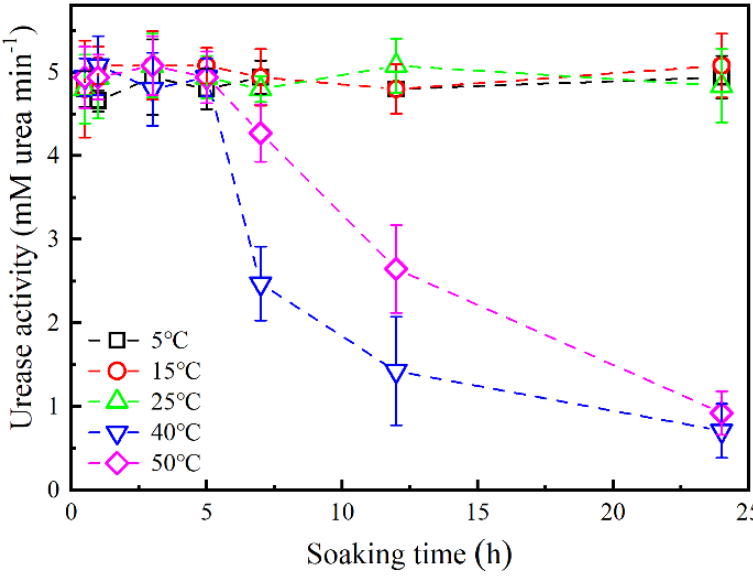
Figure 5. Effect of soaking time and temperature on the enzyme activity of soybean crude urease.